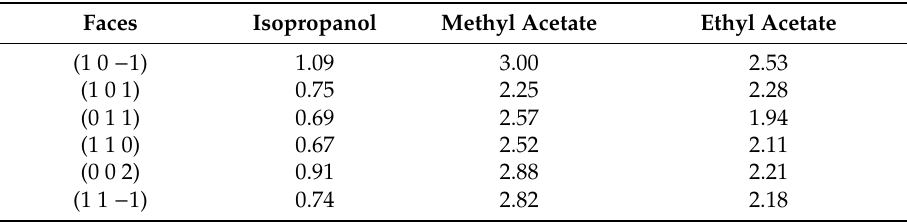
Table 5. The di ff usion coe ffi cient (D) 1 of the solvent molecules on the di ff erent catechol crystal faces. Faces Isopropanol Methyl Acetate Ethyl